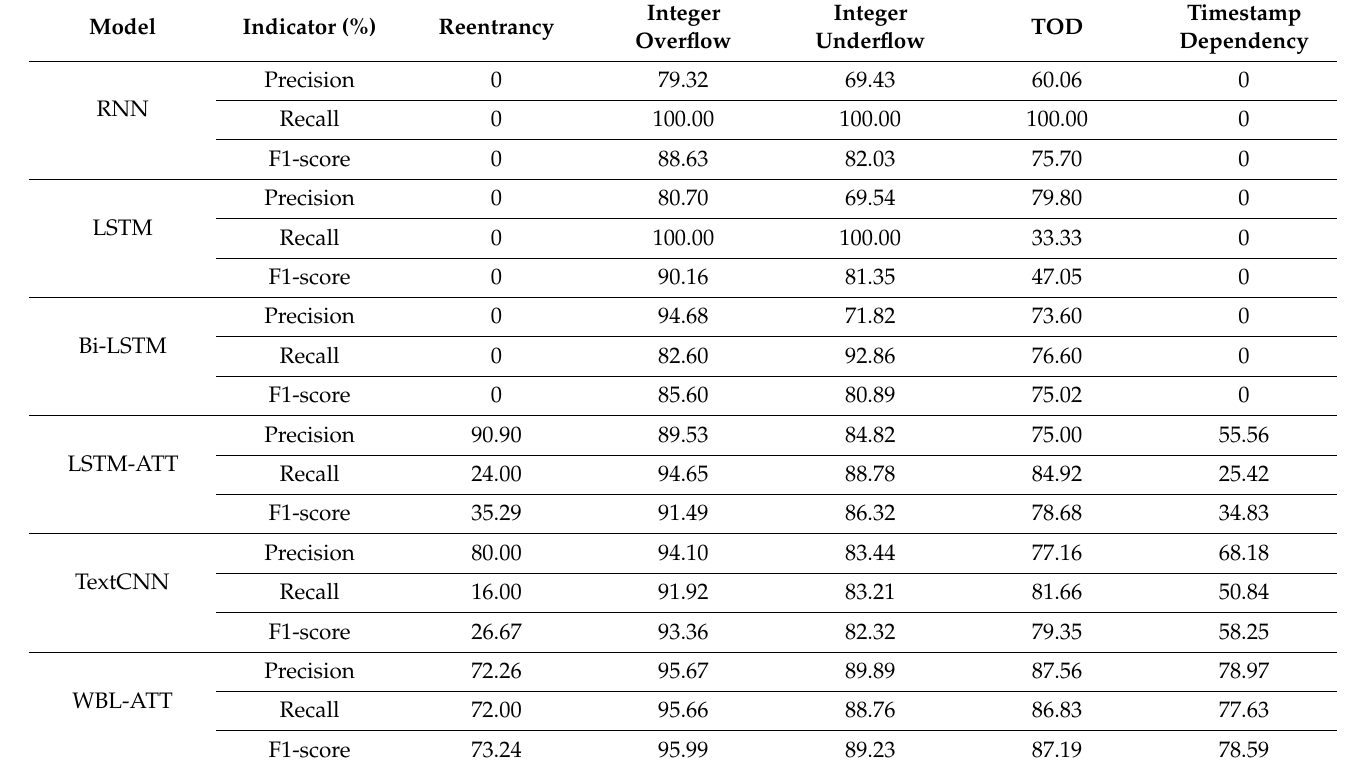
Table 8. Precision, recall and F1-score of five vulnerabilities